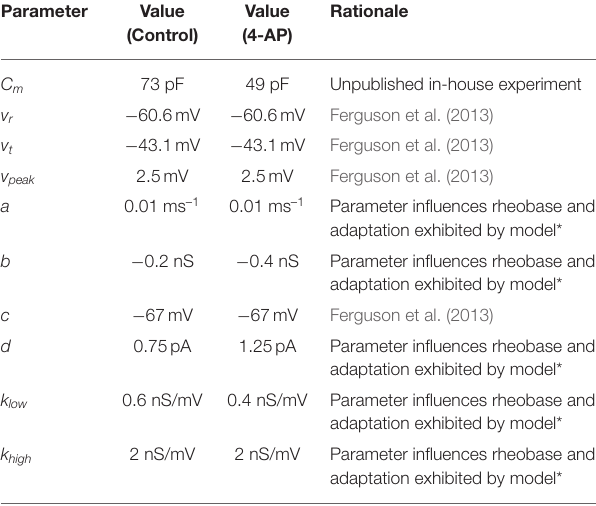
TABLE 1 | Parameters used in neuron